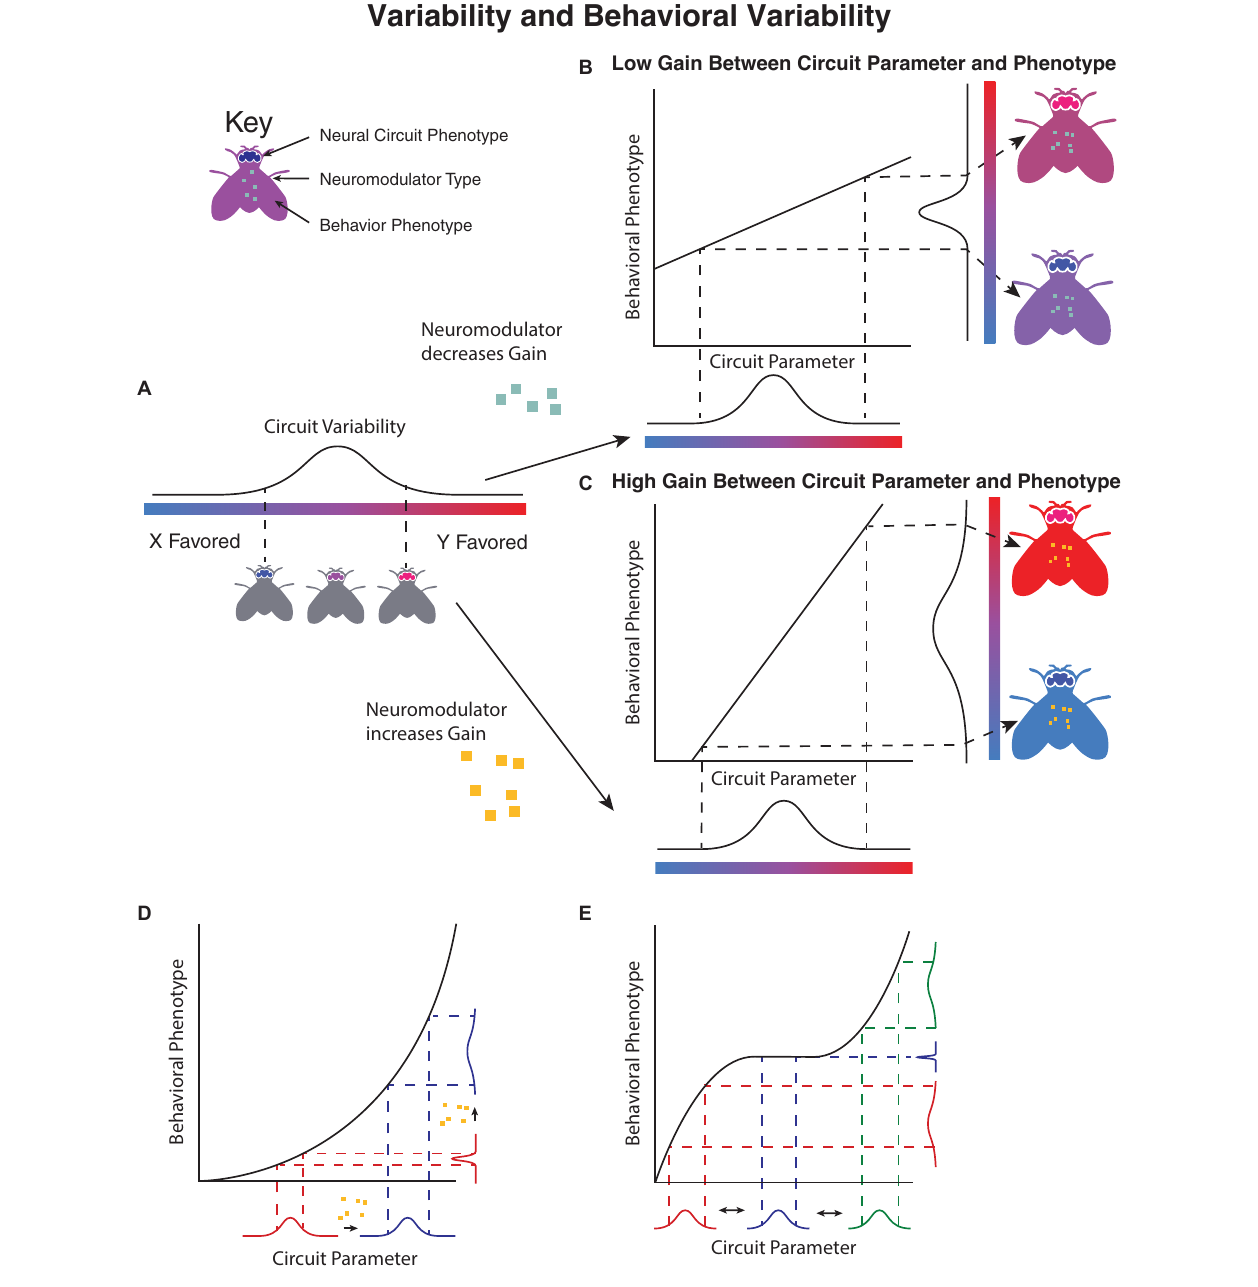
FIGURE 2 | Neuromodulators adjust the relationship between underlying circuit variability and observed variation in behavior. (A) In this model, the non-modulatory parameters of the circuit lead to a distribution of behavioral phenotypes in the absence of modulatory input. The addition of neuromodulators either decrease the slope of the relationship between the circuit parameter and behavioral phenotype (B) , leading to a decrease in the observed variability, or increase the slope of the relationship between the underlying circuit and the behavioral phenotype (C) , increasing the variability in behavior. The change in gain can occur either through by directly altering the relationship, or by altering the mean of a parameter upstream of a non-linear relationship (D) . In this example a neuromodulator shifts the mean value of a circuit parameter without altering its variance, however, due to the non-linear relationship between the circuit parameter and the observed behavioral phenotype, the variance of the behavioral phenotype is changed. (E) Shifts in parameters by neuromodulators may have inconsistent effects on the variability of observed behavior based on the starting value of the parameter and the relationship between circuit parameter and behavioral phenotype. In this example, variation in a circuit parameter (blue) under some conditions leads to no variation in the observed behavior, however, shifting the mean in either direction increases the variability in the observed behavioral phenotype as fluctuations in the parameter lead to larger changes in phenotype.